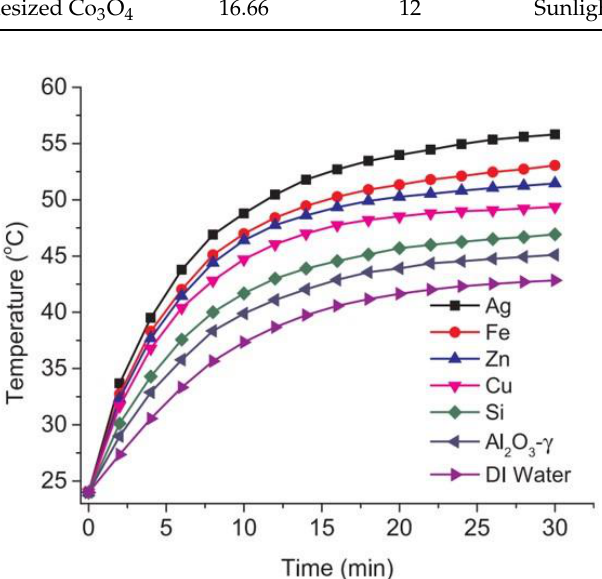
Figure 12. Variation of temperature versus time for various nanofluids [18]; 2020, Elsevier.